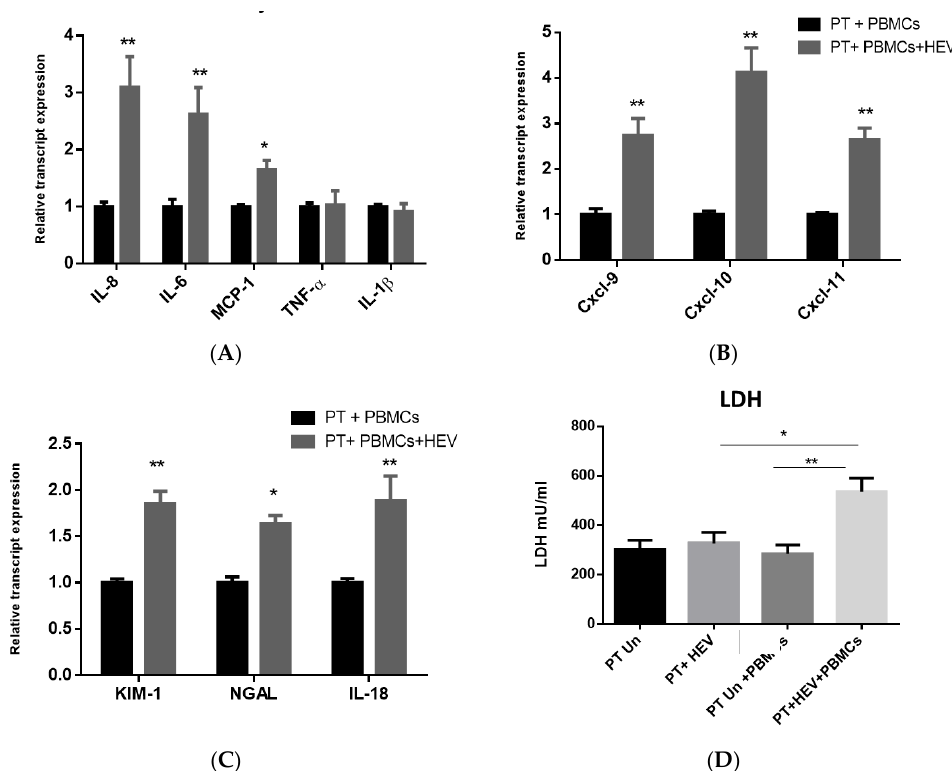
Figure 4. Coculture of PBMCs with the PT epithelial cells increased the inflammatory and kidney injury markers produced from the epithelium upon HEV infection. CD10 + /CD13 + PT cells were infected with HEV-1 for 7 days and then PBMCs from the same donors were added for an additional 3 days. Total cellular RNA was extracted from the PT cells and the mRNA expression level of proinflammatory markers (IL-8, IL-6, MCP-1, TNF-α, and IL-1β) ( A ), chemokines (Cxcl-9, Cxcl-10, and Cxcl-11) ( B ), and kidney injury transcripts (KIM-1, NGAL, and IL-18) ( C ) were assessed. The relative gene expression was determined by comparing the expression levels of these transcripts with mock cells (PT + PBMCs). Black columns represent uninfected cocultured PT / PBMCs cells, and grey columns represent HEV infected PT / PBMCs cocultured cells. Data represent the mean ± SEM of four separate experiments. *, **, indicates p ≤ 0.05 and p ≤ 0.01 as assayed by two-tailed Student’s t -test. ( D ) LDH assay was performed on PT cells either uninfected or HEV-infected in the presence or absence of coculture with